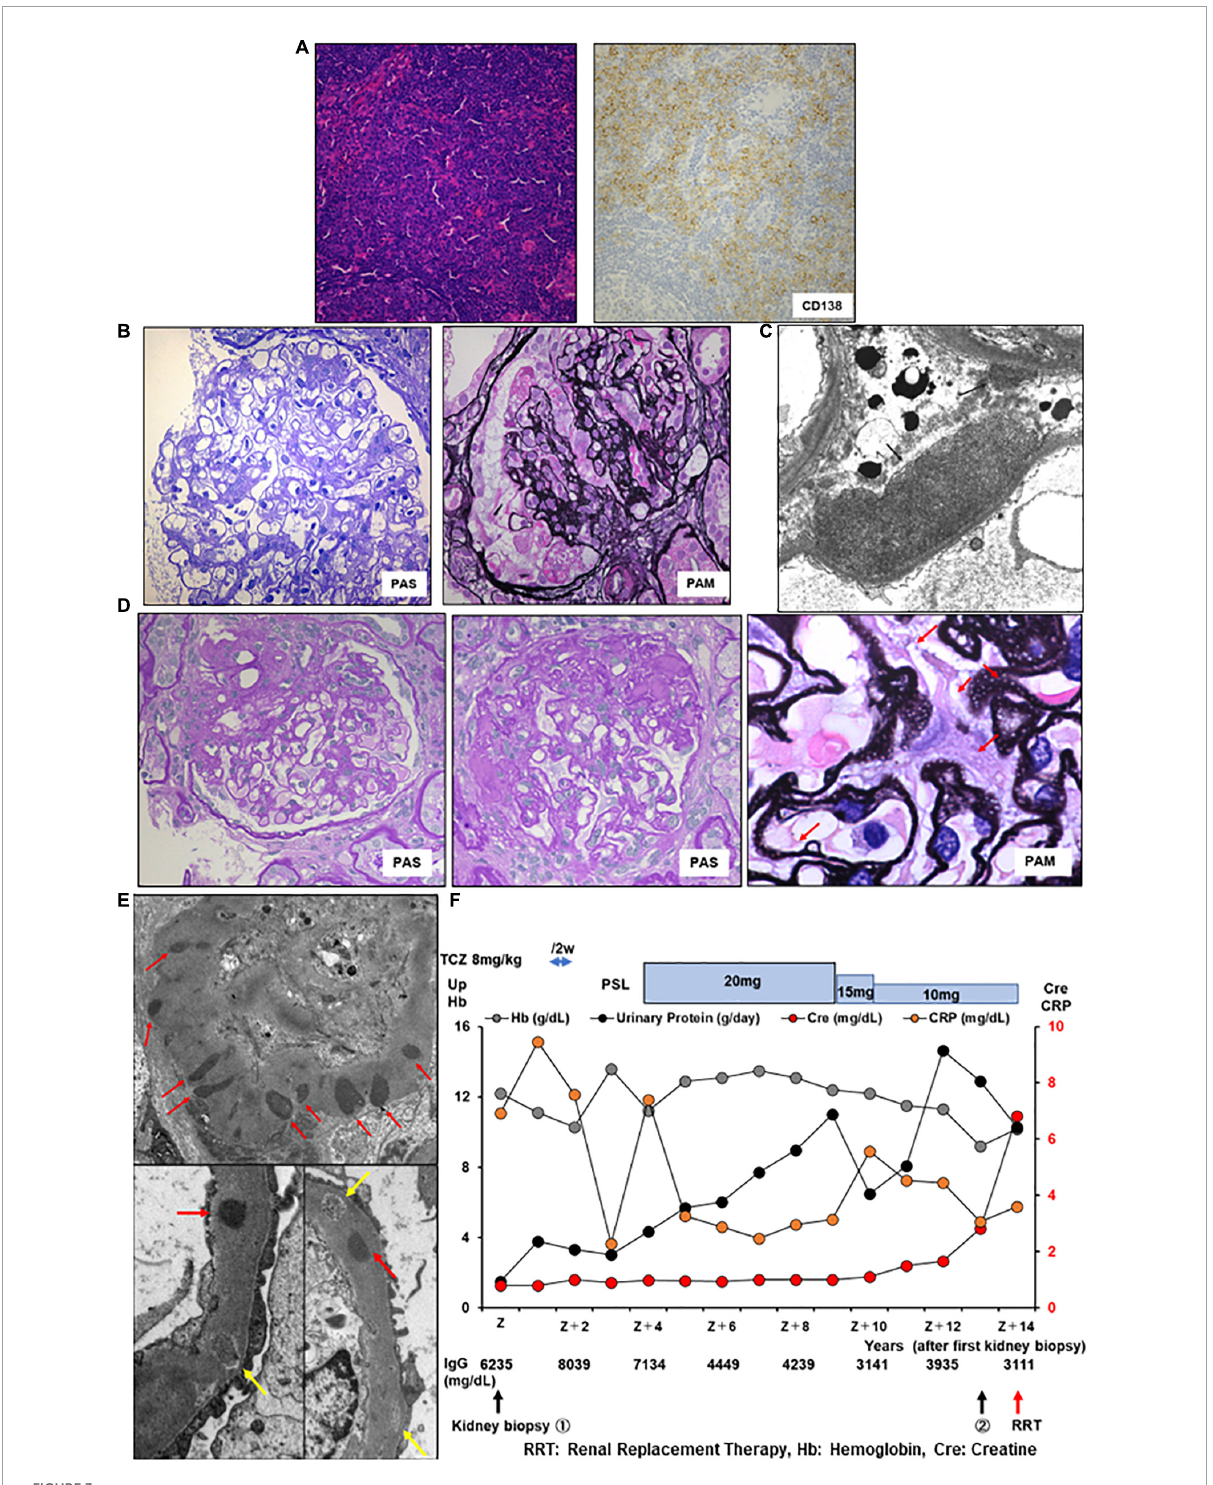
FIGURE3 Histology and time course for Case 3. (A) Light micrograph of the lymph node showing follicular hyperplasia (left lower) and infiltration by plasma cells which are positive for CD 138. (B,C) First renal biopsy. (B) Light micrograph showing slight mesangial expansion and focal segmental glomerular sclerosis. (C) Electron micrograph showing focal subepithelial deposits (arrows). (D,E) Second renal biopsy. (D) Light micrograph showing focal global and segmental sclerosis with diffuse glomerular basement membrane lucencies (red arrows). (E) Electron micrograph showing subepithelial and intramembranous deposits (red arrows). Some of the intramembranous deposits are electron-lucent and granular appearance (yellow arrows). PAS: Periodic acid–Schiff. PAM: Periodic acid methenamine. (F) Clinical time course of Case 3. Hb, hemoglobin; Cre, creatine; Up, urinary protein; RRT, renal replacement